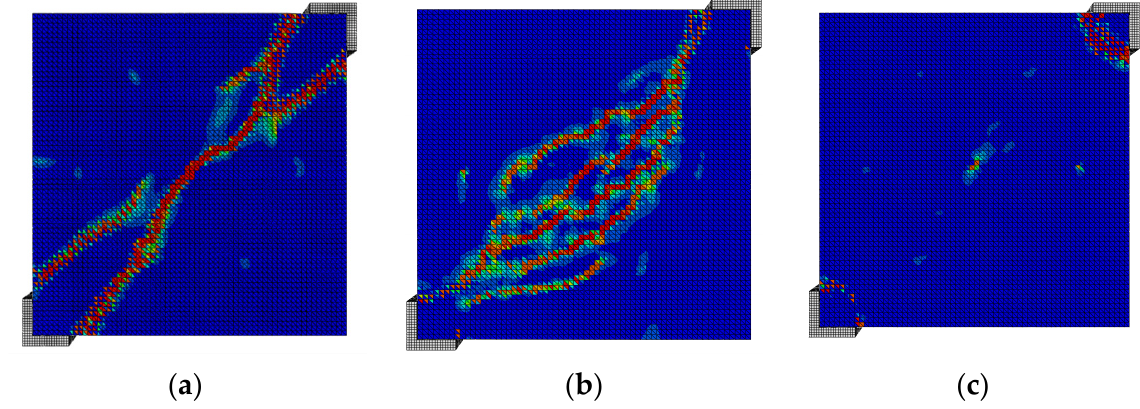
Figure 24. Damage pattern at the peak load for different configurations of reinforcement: ( a ) no reinforcement; ( b ) steel net; ( c ) fiber-reinforced plaster.